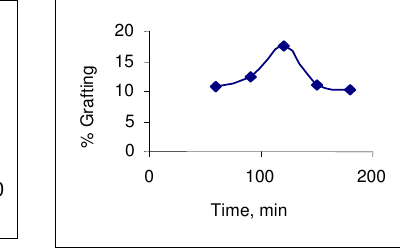
Figure 3a. Effect of temperature on Pg Figure 3b. Effect of time on Pg